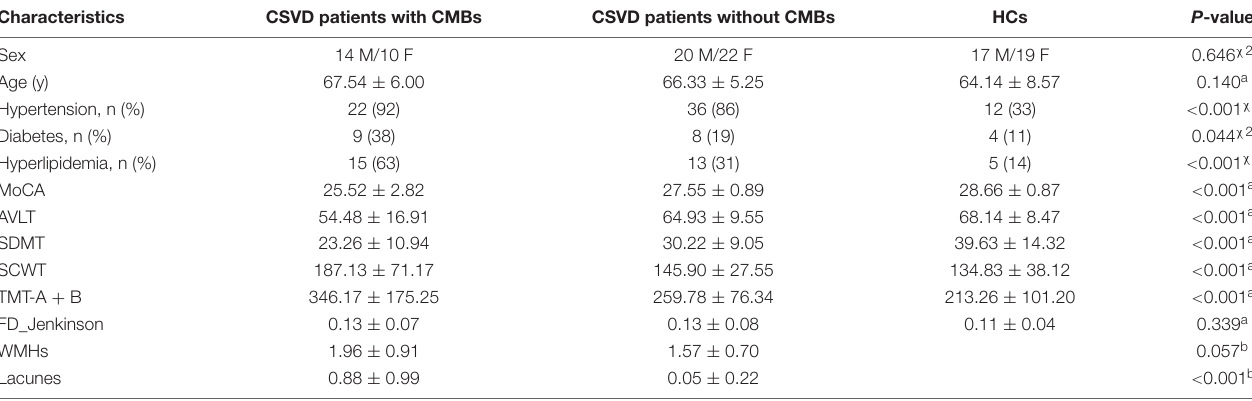
TABLE 1 | Demographic and clinical characteristics of CSVD patients and controls.